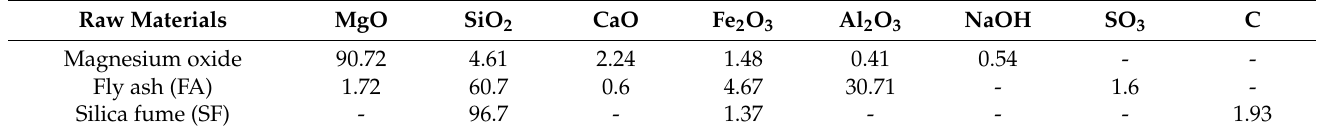
Table 1. Chemical composition of magnesium oxide, fly ash, and silica fume